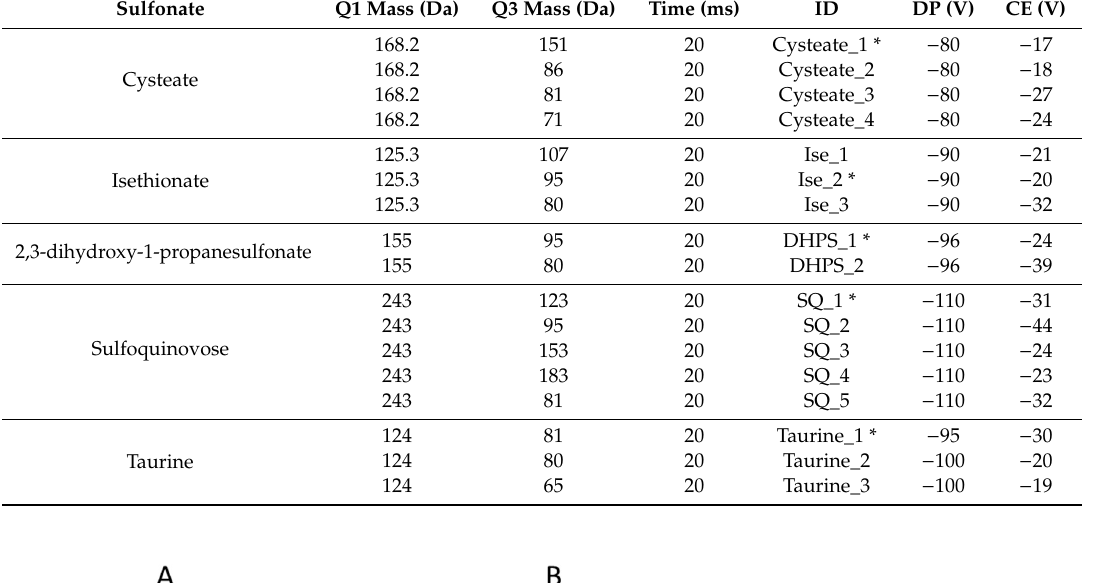
Table 1. Multi reaction monitoring (MRM)ransitions and settings for sulfonate measurements (* transitions used as quantifiers). DP, declustering potential; CE, collision energy. Ionization mode was negative.